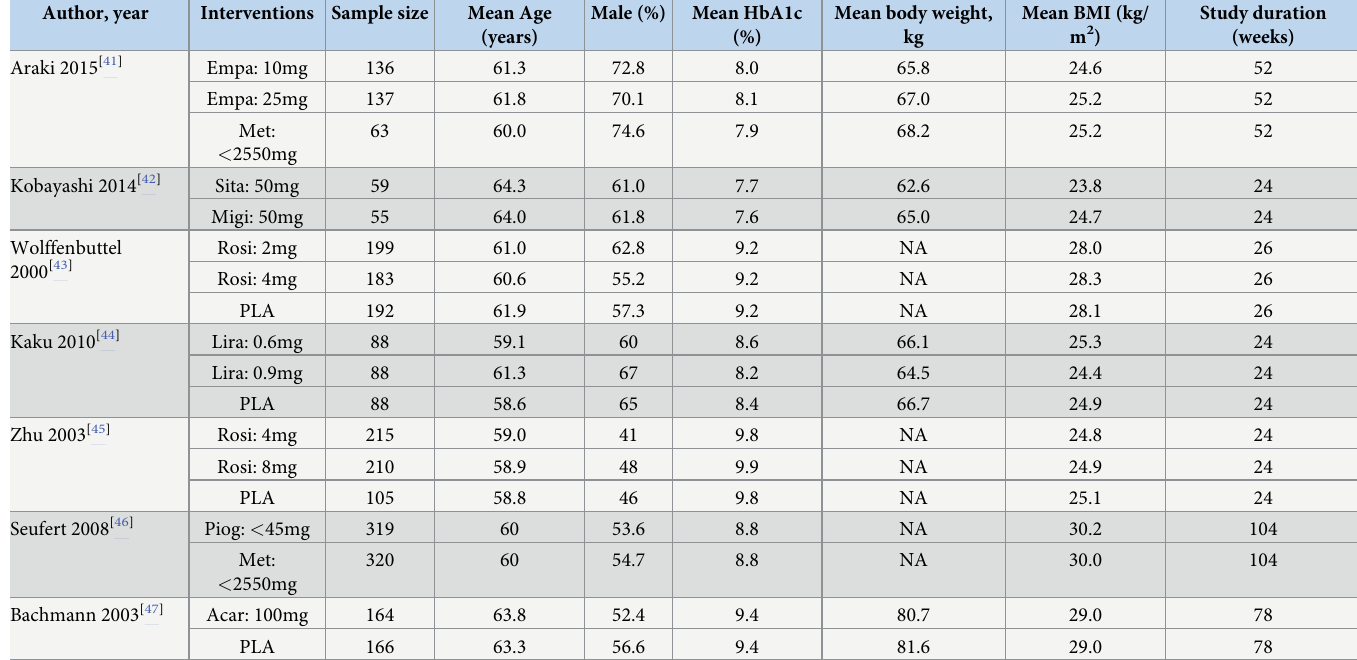
Efficacy outcomes: HbA1c, FPG, and body weight HbA1c data were available from 8930 patients in 23 RCTs (S4 Table). In direct pairwise meta- analyses, the largest HbA1c reduction was observed with GLP-1RA versus placebo [-1.05% (95% CI: -1.35 to -0.76)]. In comparisons of other antidiabetic drugs, the significant differences ranged from a reduction of -0.30% (95% CI: -0.55 to -0.05) for basal insulin versus DPP-4i to -0.49% (95% CI: -0.64 to -0.34) for GLP-1RA versus TZD (S12 Table). The NMA indicated that when compared to placebo, all drug classes were associated with greater reductions in HbA1c levels when combined with SU. Comparisons among the second-line agents in combi- nation with SU revealed greater HbA1c reductions with GLP-1RA versus SGLT-2i [-0.47% (95% CI: -0.85 to -0.09)], DPP-4i [-0.45% (95% CI: -0.73 to -0.16)], and AGI [-0.53% (95% CI: -0.91 to -0.15)]. No significant differences were observed for the other comparisons between second-line agents combined with SU (Table 2 and Fig 3). Notably, GLP-1RA and basal insulin yielded the greatest reductions in HbA1c, with SUCRA values of 94% and 75%, respectively (Table 3). Nineteen RCTs with a total of 6611 participants reported changes in FPG (S4 Table). Direct pairwise meta-analyses (versus placebo) showed significant reductions in FPG with all second- line agents combined with SU, ranging from -2.77 mmol/l (95% CI: -4.14 to -1.40) for TZD to -0.62 mmol/l (95% CI: -0.78 to -0.47) for DPP-4i. When compared with other antidiabetic drugs, the only significant difference was observed for SGLT-2i versus Met [-0.44 mmol/l (95% CI: -0.73 to -0.15)] (S12 Table). The NMA revealed that compared with placebo, all drug classes were associated with greater reductions in HbA1c levels when combined with